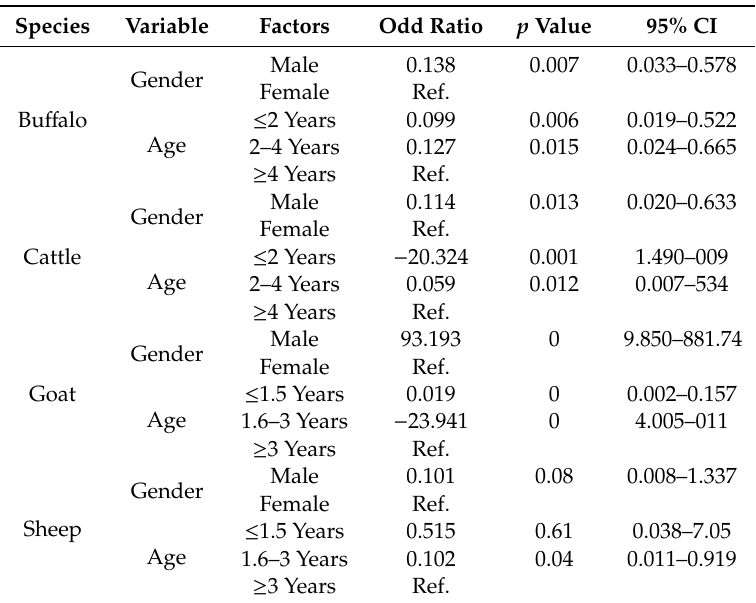
Table 3. Association of gender and age of bu ff aloes, cattle, goats, and sheep with Brucella prevalence based on Multiple Logistic Regression Analysis for the Punjab, Pakistan.